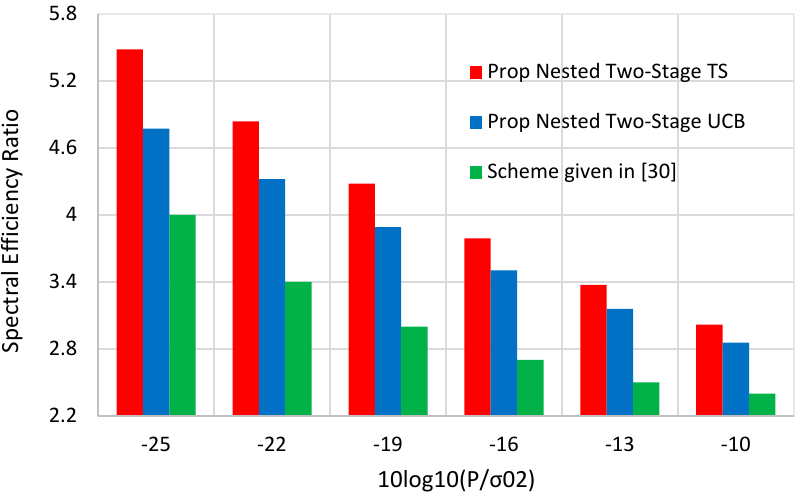
Figure 12. Spectral efficiency comparisons between the proposed nested two-stage MAB schemes and the scheme proposed in [30].